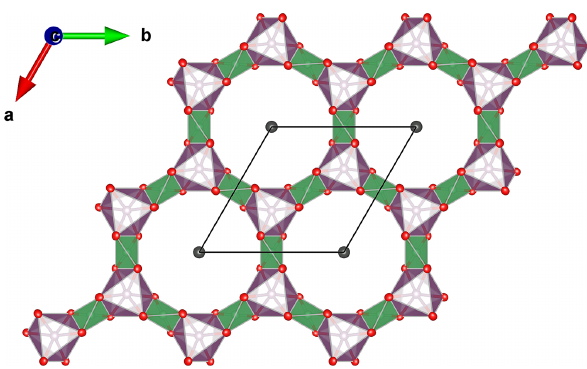
Figure 7. The A − T (2) layer forming 12 rings. These rings are aligned with six-membered double Si rings along [0001]. C sites are located at the centre of these channels. T (2) sites are shown in green; A sites are shown in pink. Diagram obtained with VESTA 3.0 (Momma and Izumi,